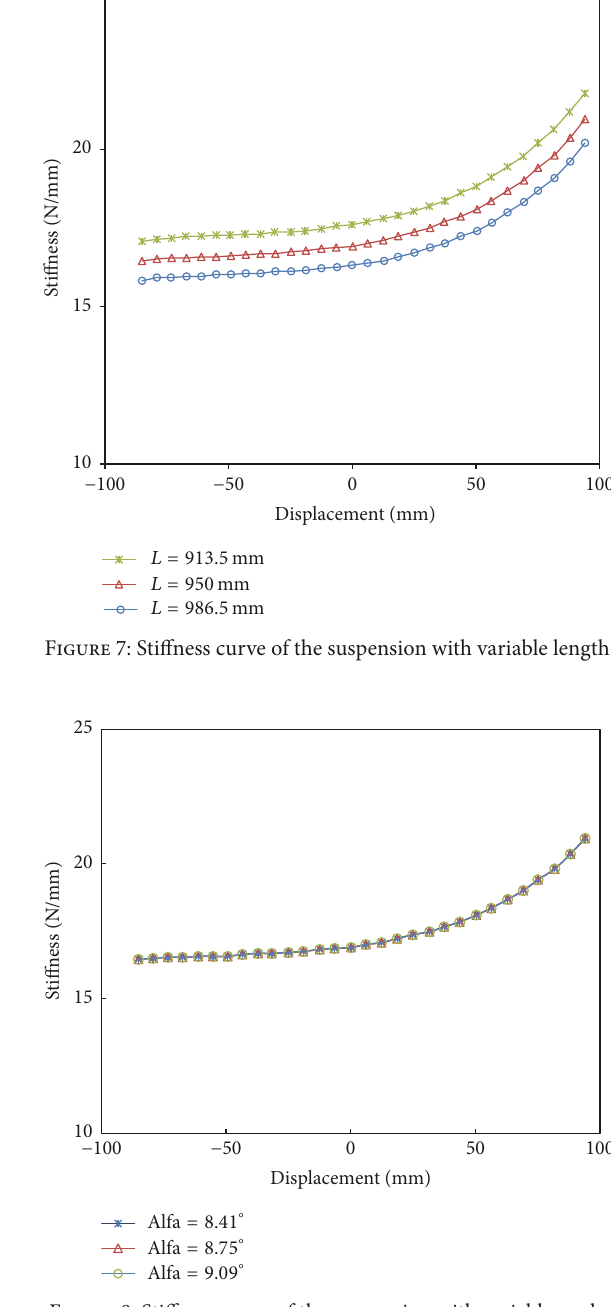
Figure 8: Stiffness curve of the suspension with variable